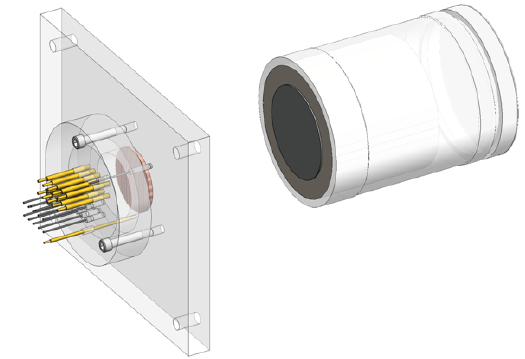
Figure 5. Left : Image showing the sample in the lexan plate that is used to mount the target in the gun along and right along with full the diagnostic assembly. Right : the projectile with the tantalum